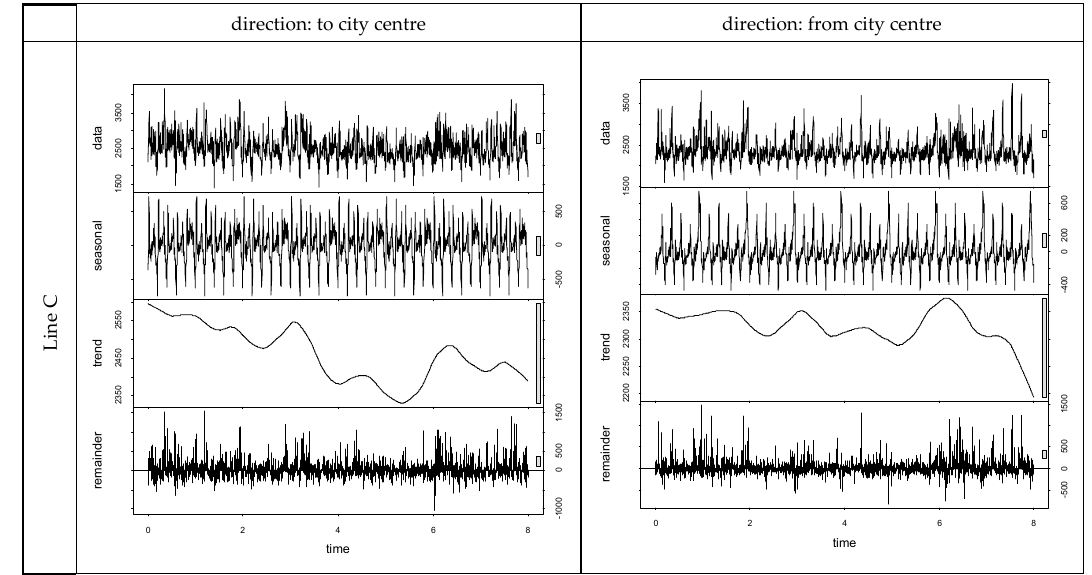
Figure 5. Travel time STL decomposition with weekly period (8 weeks): Lviv.